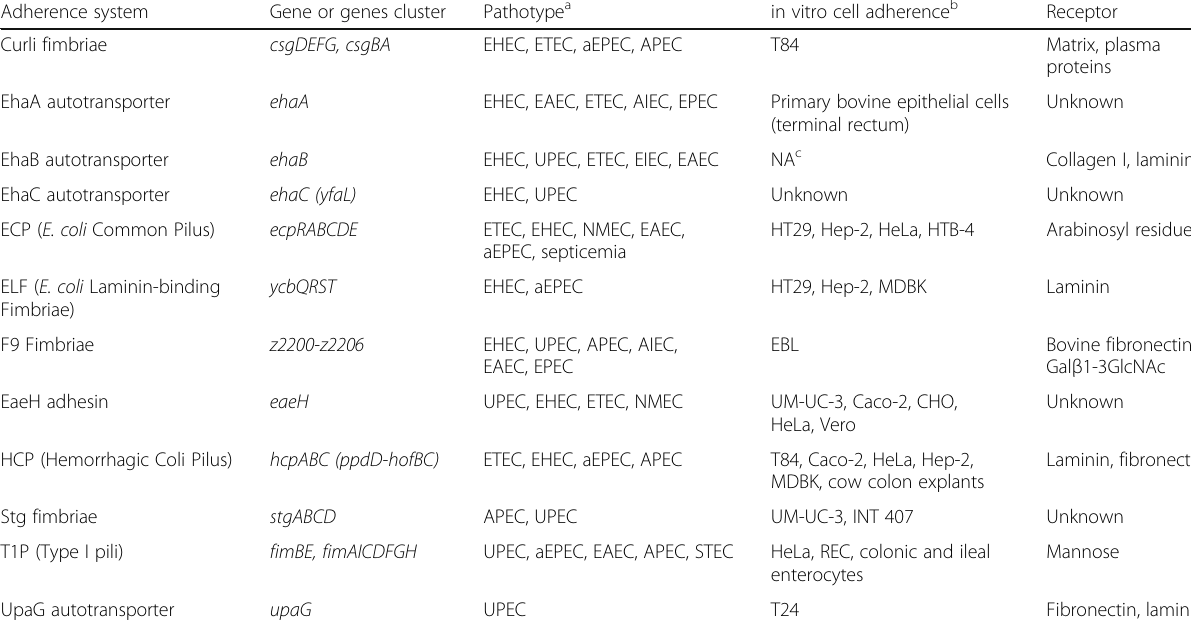
Table 6 Adherence systems encoded by the E. coli BG1 genome Adherence